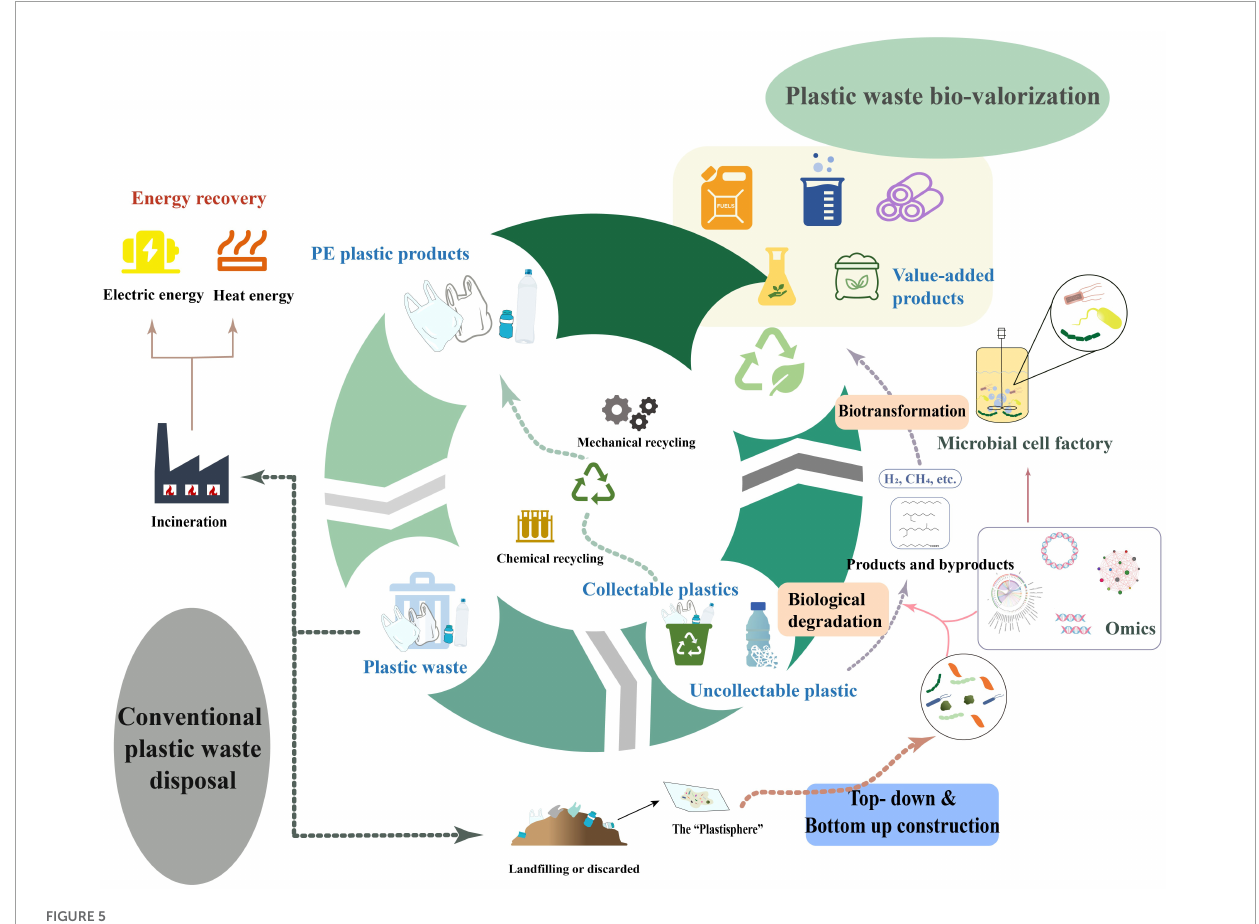
FIGURE5 A general overview of plastic waste